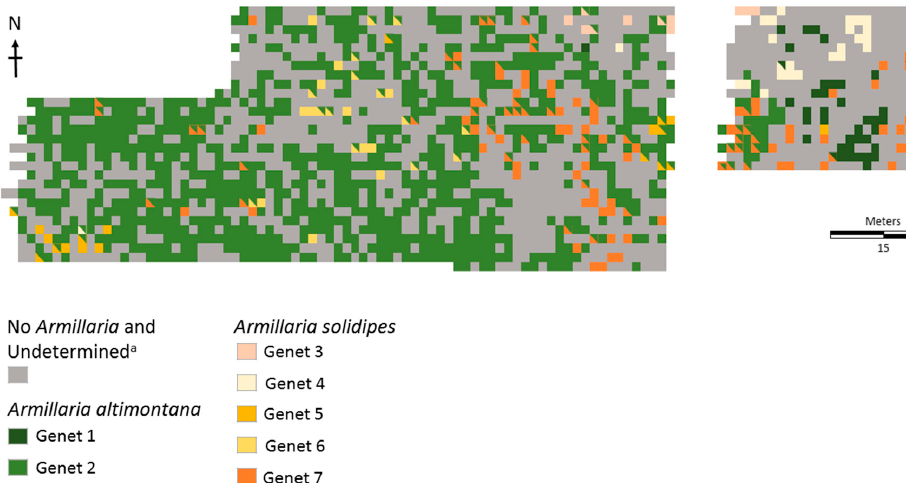
Figure 1. The Armillaria species and genet distribution within the Ida Creek plantation (0.8 ha) at the Priest River Experimental Forest, Idaho, USA: Each square pixel represents 1.2 m × 1.2 m (a single tree location), and the colored pixels indicate trees associated with Armillaria altimontana , A. solidipes , or both. Cells split diagonally show the two unique genets that were identified on that single tree. The grey pixels indicate trees where neither A. altimontana nor A. solidipes were found or trees that were either missing or died early from unknown causes. The sequences ( tef1 ) from G1–G7 (MH879011–MH879017) are deposited in GenBank.